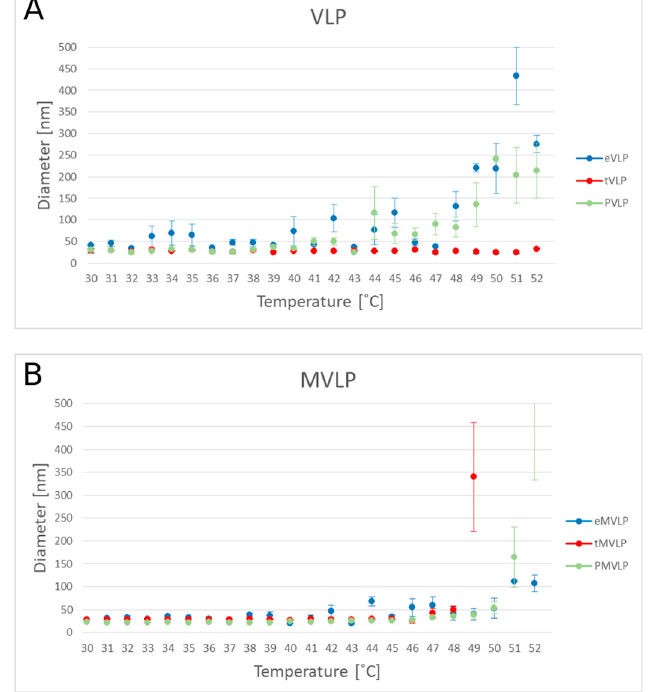
Figure 8. BMV-based VLPs size as a function of temperature. The diameter of VLPs was measured by DLS through a gradient of increasing temperature (30–52 °C). Wild type VLPs ( A ) and mutated VLPs ( B ). Empty VLPs (eVLPs ( A ) and eMVLPs ( B )) are in blue, VLPs with tRNA (tVLPs ( A ) and tMVLPs ( B )) are in red, and VLPs with PSS (PVLPs ( A ) and PMVLPs ( B )) are in green.